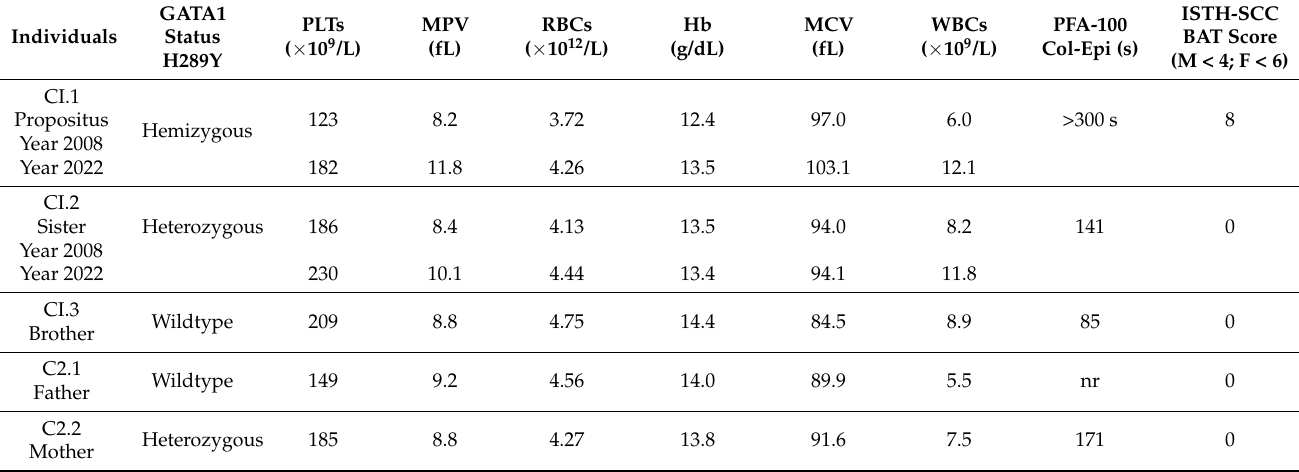
Table 3. Pedigree C, laboratory